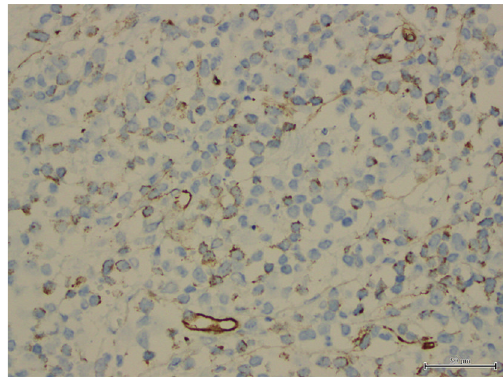
Figure 5: Neoplastic cells staining positive for CD34.